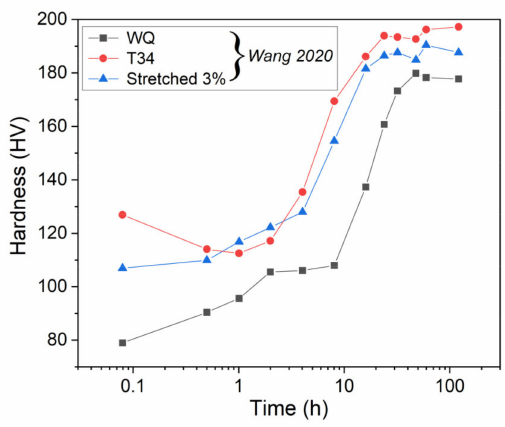
Figure 7. The hardness evolution in WQ, T34, and Stretched 3% samples during heat treatment at 155 ◦ C as measured by Wang et al. [11].